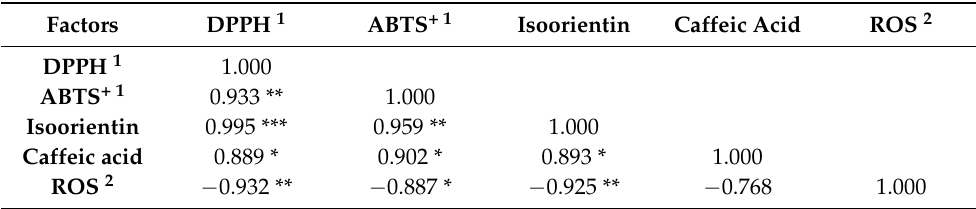
Table 3. Correlations among antioxidant activities, isoorientin content, caffeic acid content, and ROS generation in PC12 cells.